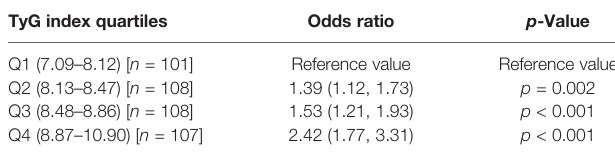
TABLE 2 | Quartiles of triglyceride-glucose index and the risk of breast cancer. TyG index